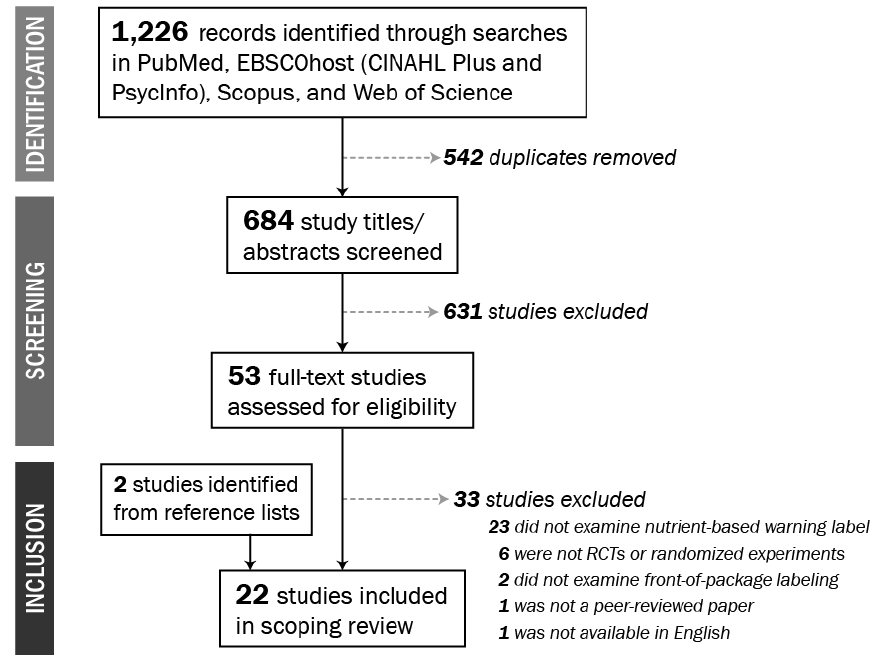
Figure 3. Study selection.